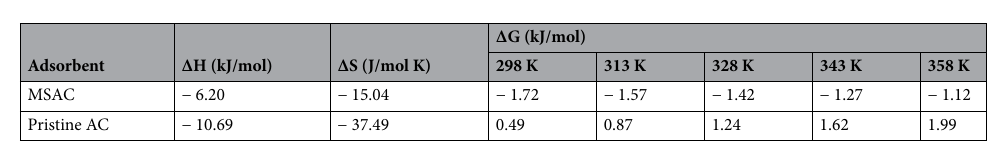
Table 1. Thermodynamic parameters of phenol adsorption onto MSAC and pristine activated carbon at different